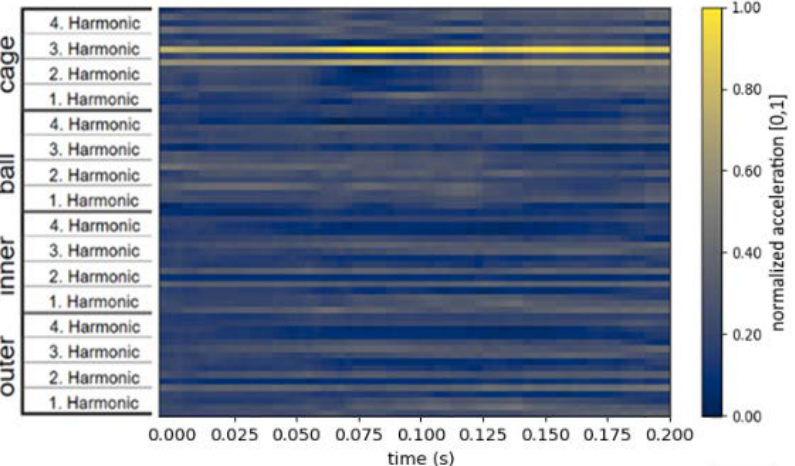
Figure 5. An exemplary intermediate domain image for bearing data with four harmonics for each of the four fault frequencies.